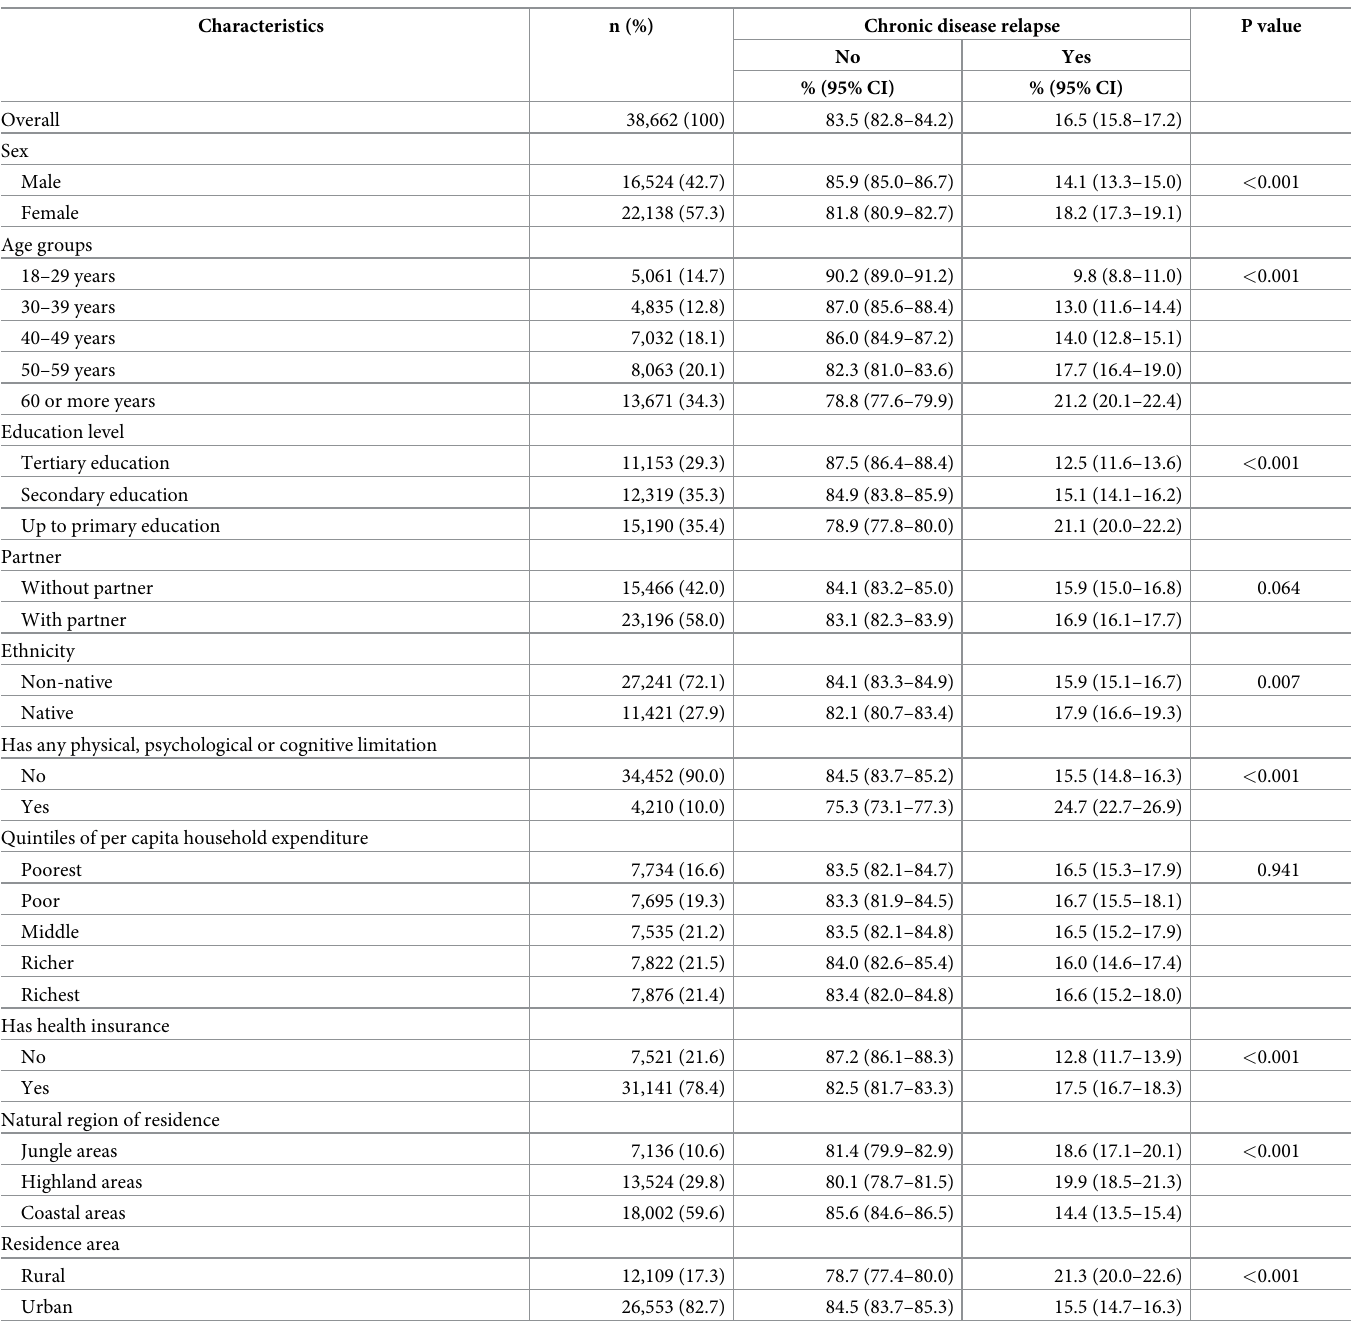
Table 1. Characteristics of the participants included in the